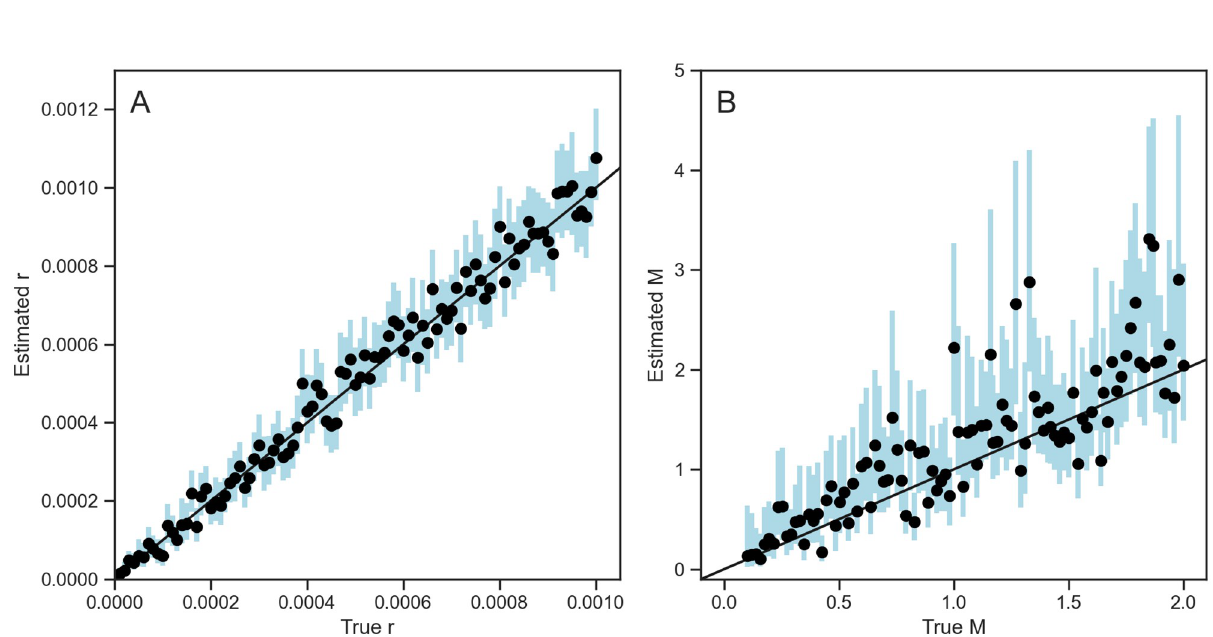
Fig 5. Joint estimation of recombination and migration rates together. Dots and blue bars represent the median posterior estimates and the 95% credible intervals of the marginal posterior distribution of each parameter from each simulation.